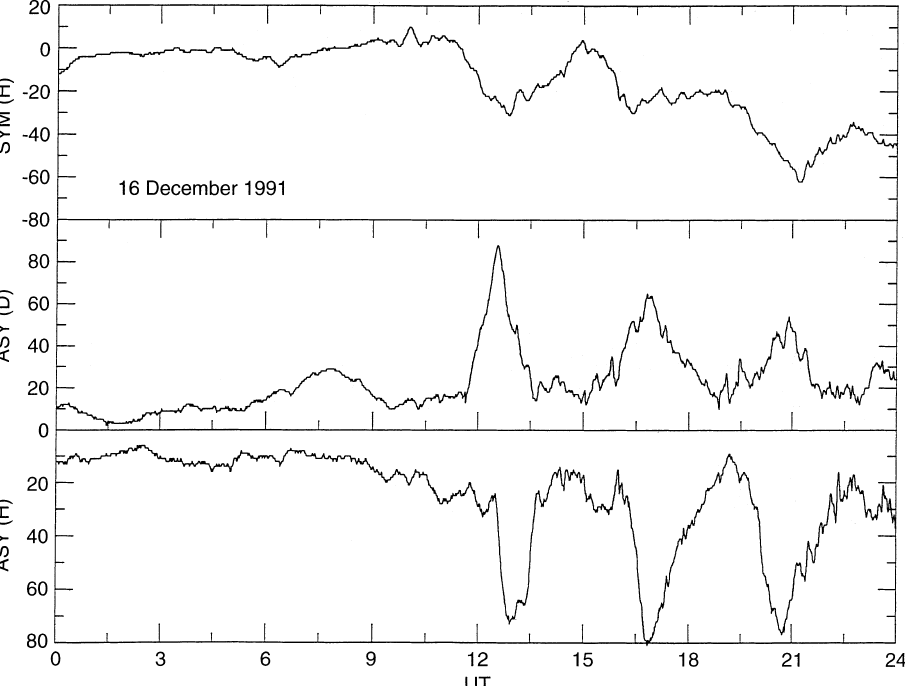
Fig. 1. Time histories of the asymmetric ring current indices, ASY( H ) and ASY( D ) and sym- metric ring current index, SYM( H ) on 16 December 1991 (Ap = 20) based on 1-min resolution data. Note the occurrence of three suc- cessive and distinct asymmetric/ symmetric ring current intensifica- tions preceded by